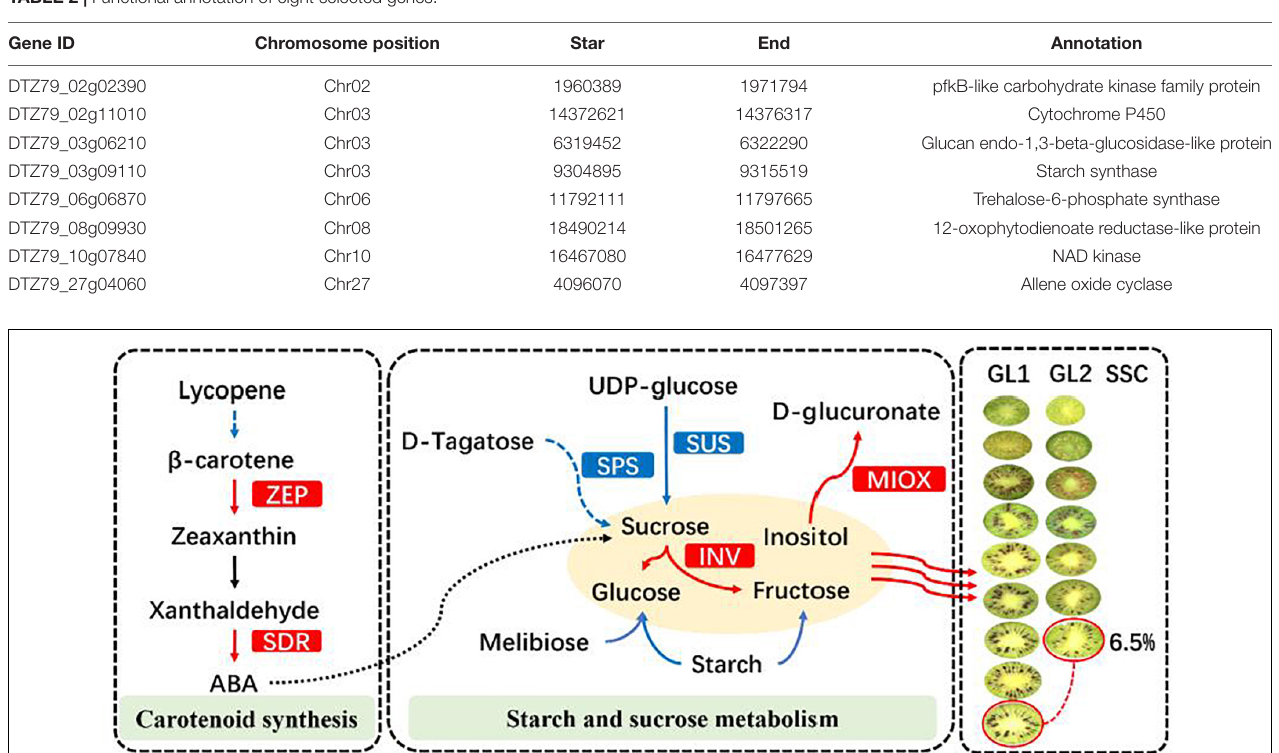
FIGURE 10 | Some of the biological pathways involved in early mature in A. eriantha . The red box represents inhibition, and the blue box represents promotion.